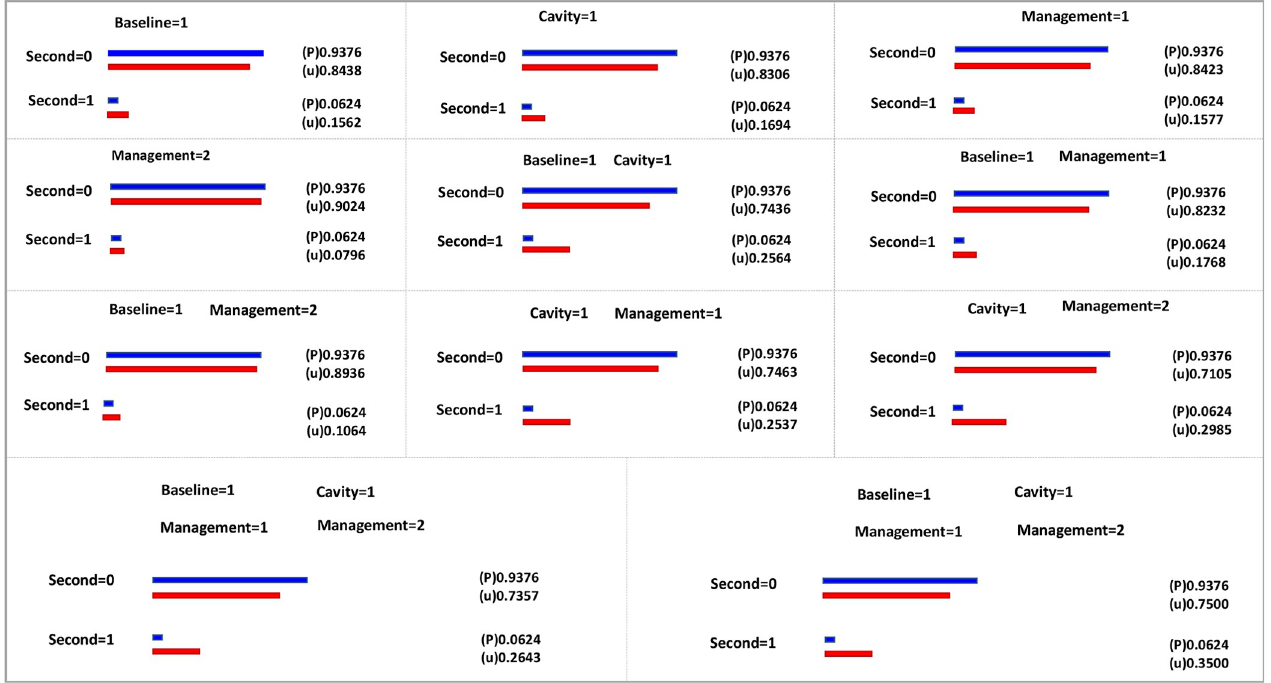
Fig 4. Conditional probability table of second AFB